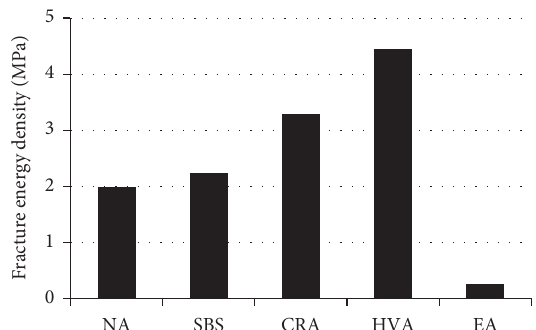
Figure 28: Failure in underlying asphalt mixture during the Pull test